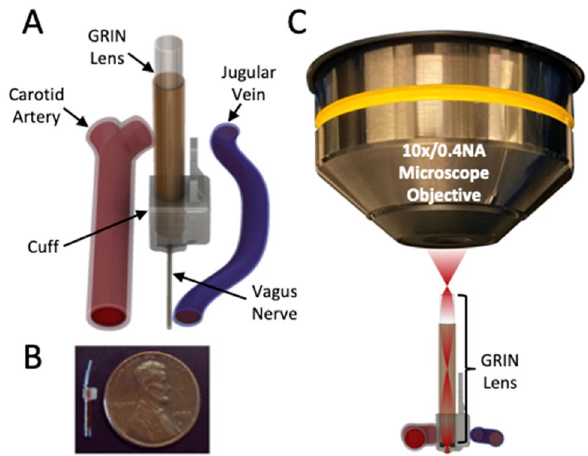
Figure 1. Detailed schematic of the GRIN-lens-integrated nerve cuff for two-photon imaging and holographic stimulation. ( A ) GRIN-cuff situated on the cervical vagus nerve between the carotid artery and jugular vein. ( B ) Photo of device next to penny for scale, in the un-cuffed (non-ratcheted) position. ( C ) Schematic of GRIN-cuff and microscope objective